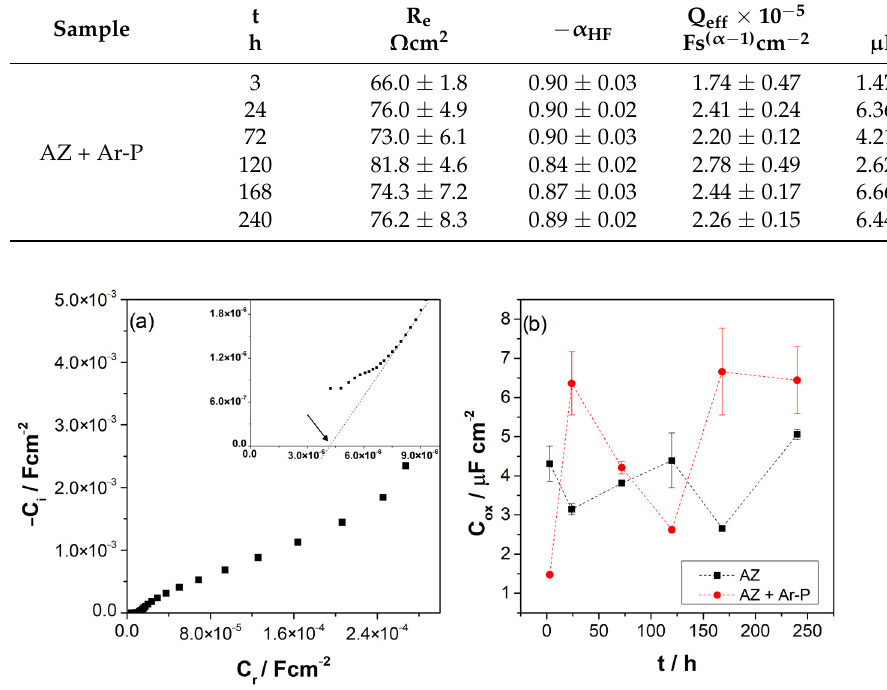
Figure 7. ( a ) A representative Cole-Cole plot of AZ samples after 3 h of immersion, as an example for the determination of C ox ; ( b ) Evolution of complex capacitance (C ox ) for the differently pretreated AZ31 alloy immersed in 0.1 M of Na 2 SO 4 .